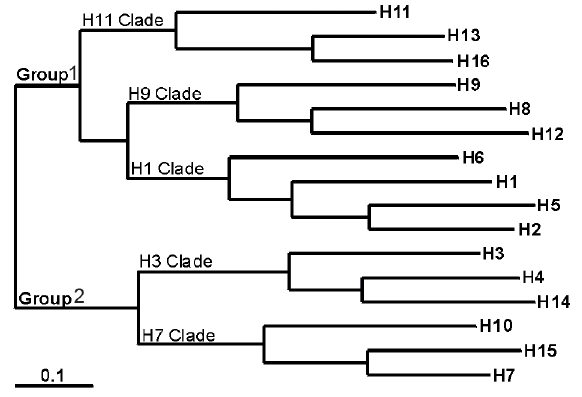
Figure 1. DNA maximum-likelihood trees of the HA segment. illustrating relationships between IAV hemagglutinin subtypes. Branch lengths represent the number of nucleotide substitutions between close HA subtypes (scale bars represent 10% of nucleotide substitu- tions). Adapted from Fouchier et al. 2005.